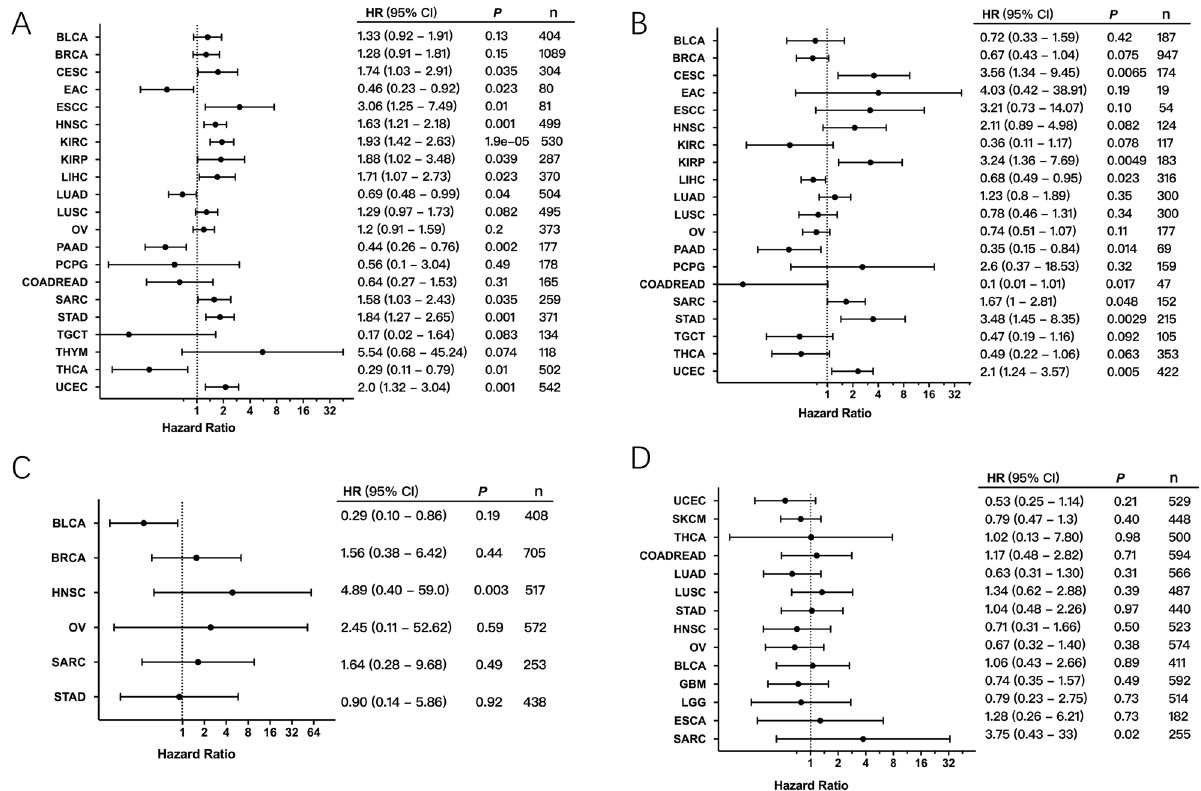
Figure 9. The correlation between RET alterations and patient survival. ( A ) The correlation between RET mRNA expression and overall survival (OS) of patients with indicated cancers. ( B ) The association between RET mRNA expression and recurrence -free survival (RFS) of patients with indicated cancers. ( C ) The relation between RET amplification and patient OS in different cancers. ( D ) The association between RET somatic mutation and patient RFS in different